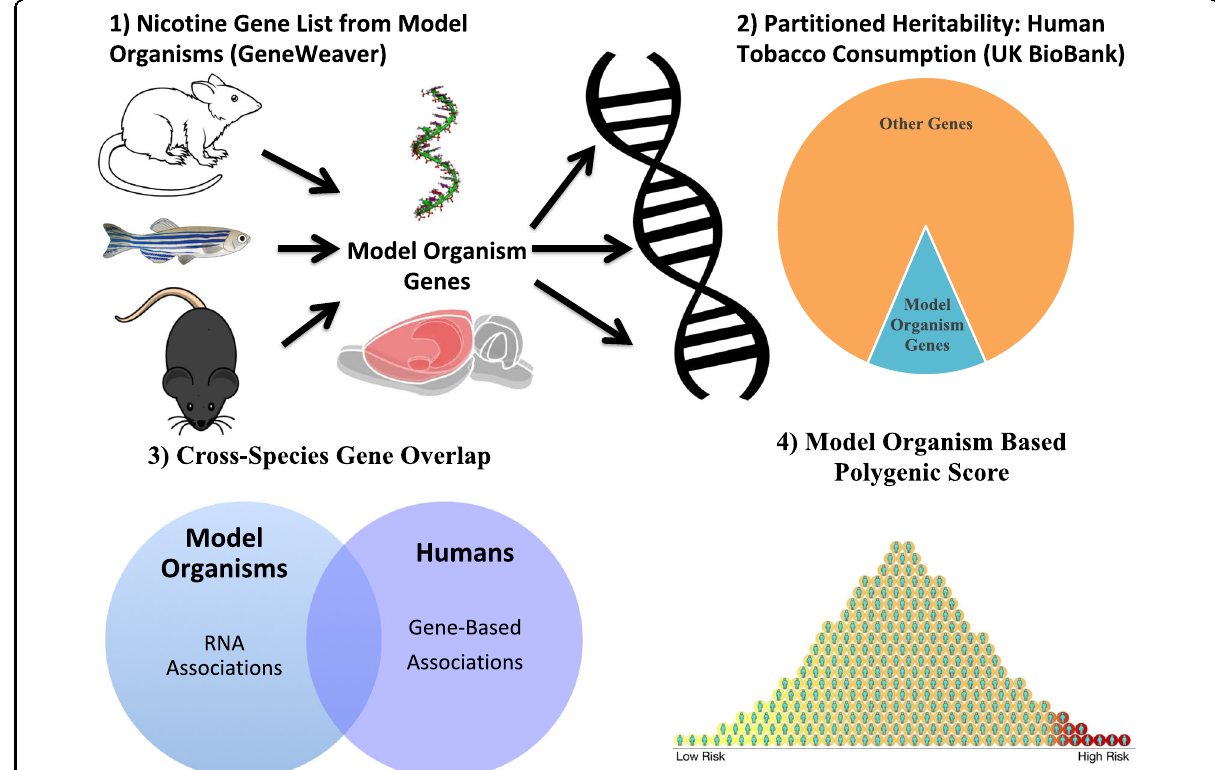
Fig. 1 Schematic outlining our study design. Schematic of analytical pipeline used for cross-species analysis. Panels indicate: 1) Derivation of gene list using genes associated with nicotine exposure from various animal paradigms. 2) Multicomponent SNP-heritability analysis in UKBiobank smokers using mixed linear models. 3) Examination of gene-list overlap using Jaccard similarity and Fisher exact tests. 4) Multicomponent polygenic score analysis using GWAS-LOCO summary statistics in an independent